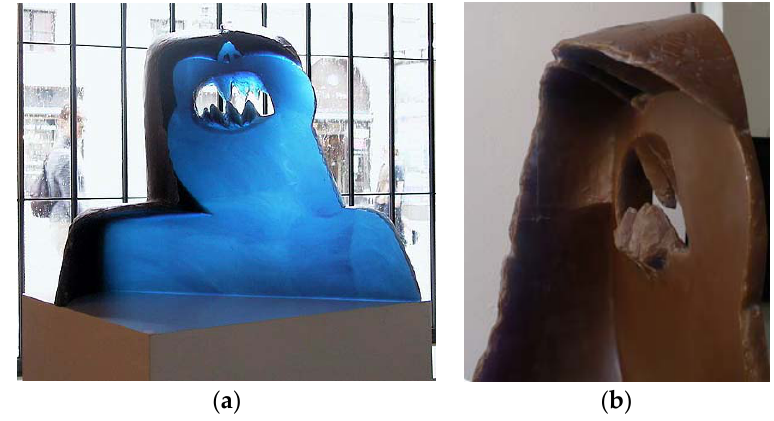
Figure 1. Stanislav Libenský and Jaroslava Brychtová, Silhouettes of the Town III, 1989. Photographs by the author. ( a ) In transmitted light. ( b ) In reflected light.